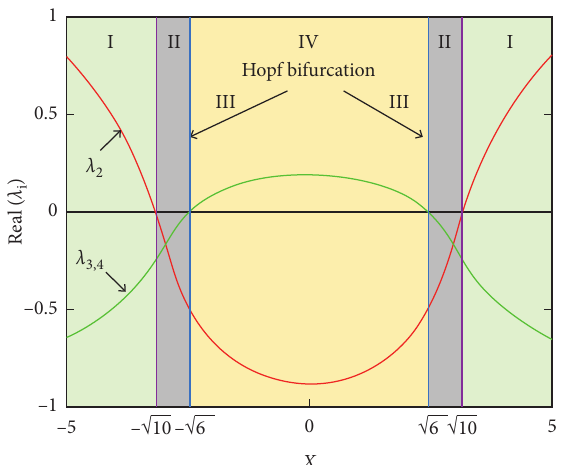
Figure 3: Stability distribution of the equilibrium points of memristive hyperjerk system